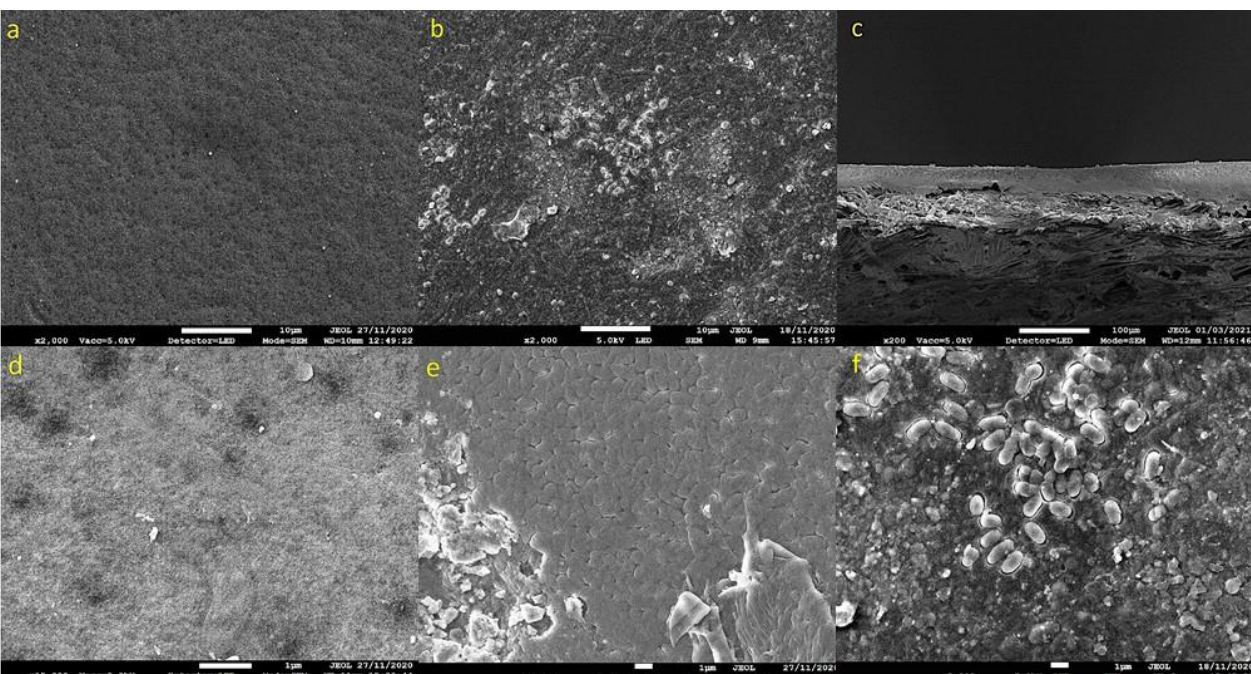
Figure 7. Scanning electron microscopy images for the Nadir US100 membrane. ( a ) Surface mor- phology of the clean membrane; ( b ) surface morphology of fouled membrane with cake layer; ( c ) cross-section of fouled membrane showing cake layer; ( d ) surface morphology of the membrane following one filtration and washing cycle; ( e ) surface morphology of the membrane after four filtration and washing cycles; and ( f ) surface morphology of the membrane following filtration but without